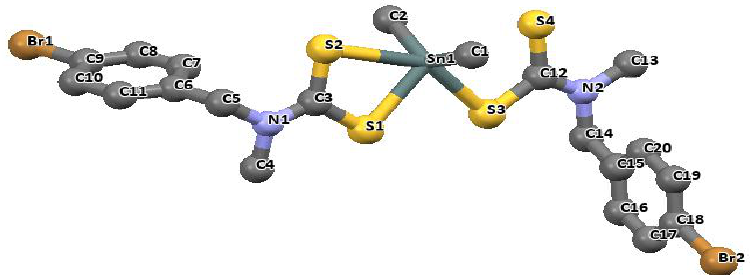
Figure 6. The molecular structure of dimethyltin(IV) bis( p -bromo- N -methylbenzylamine dithiocarbamate). (For clarity, H atoms were omitted). Redrawn from [83], with permission from Elsevier (Copyright 2018).